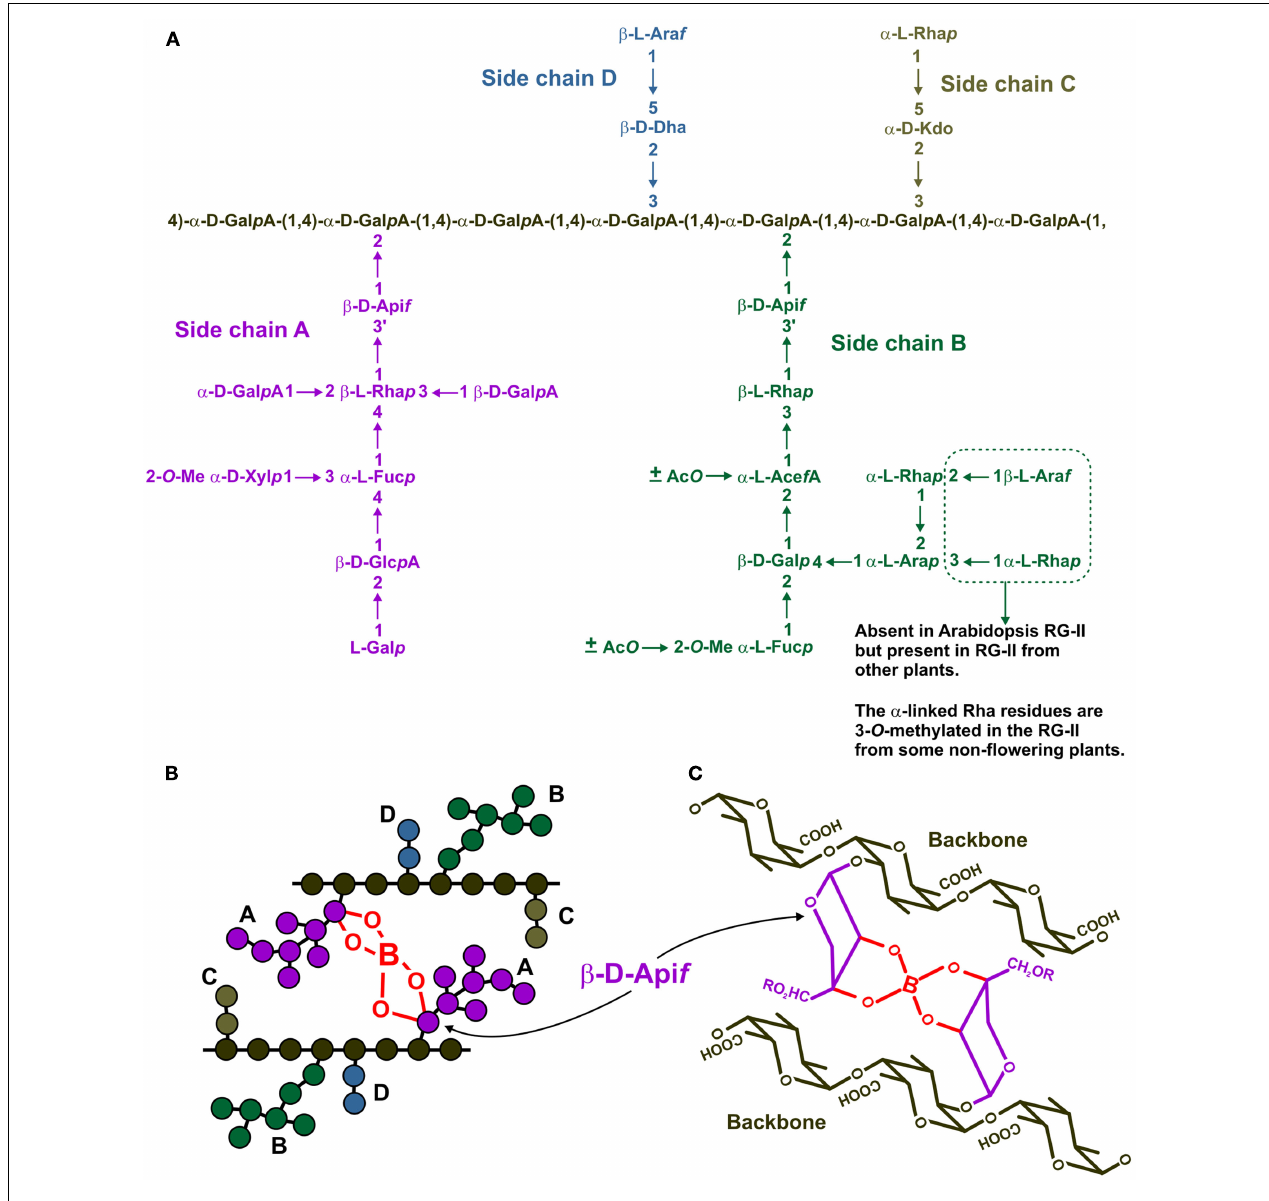
and two diastereoisomers (bis[3- C -(hydroxymethyl)- β -L threo -furanoside]-(R)-2,3:2 (cid:2) ,3 (cid:2) borate) and (bis[3- C -(hydroxymethyl)- β -L- threo -furanoside]-(S)-2,3:2 (cid:2) ,3 (cid:2) borate may form (O’Neill et al., 2004). It is not known if one or both diastereoisomers are formed when RG-II is cross-linked in the cell